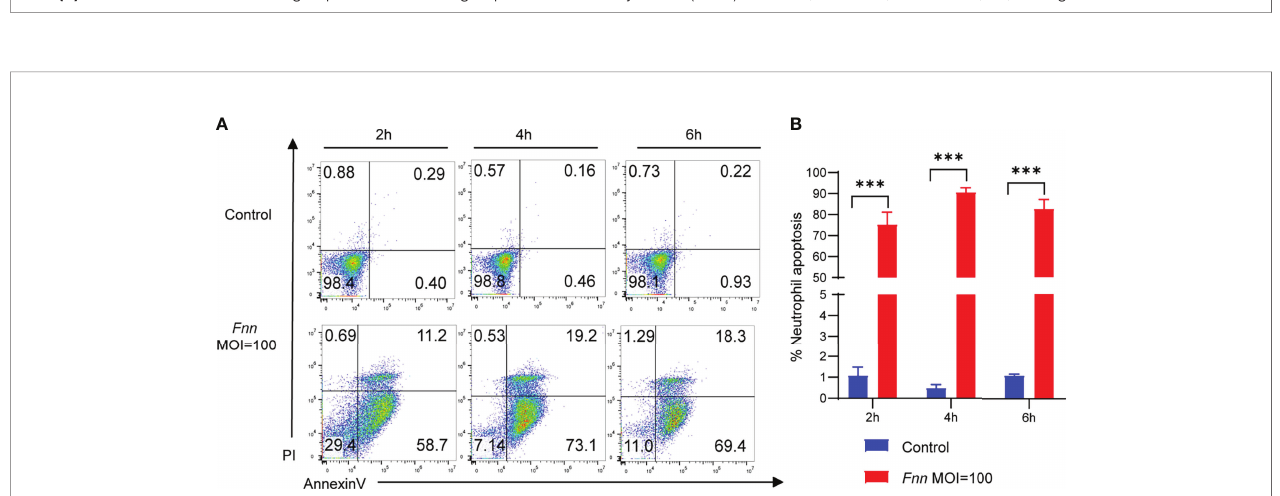
FIGURE 5 | Apoptosis of sheep neutrophils cells induced by F. necrophorum (MOI=100). (A) Flow cytometry analysis of sheep neutrophil cells apoptosis with F. necrophorum stimulation (MOIs of 0 and 100) at 2, 4, and 6 h. (B) Statistical analysis of sheep neutrophils apoptosis with F. necrophorum stimulation (MOIs of 0 and 100) at 2, 4, and 6 h. (n = 3). *** P